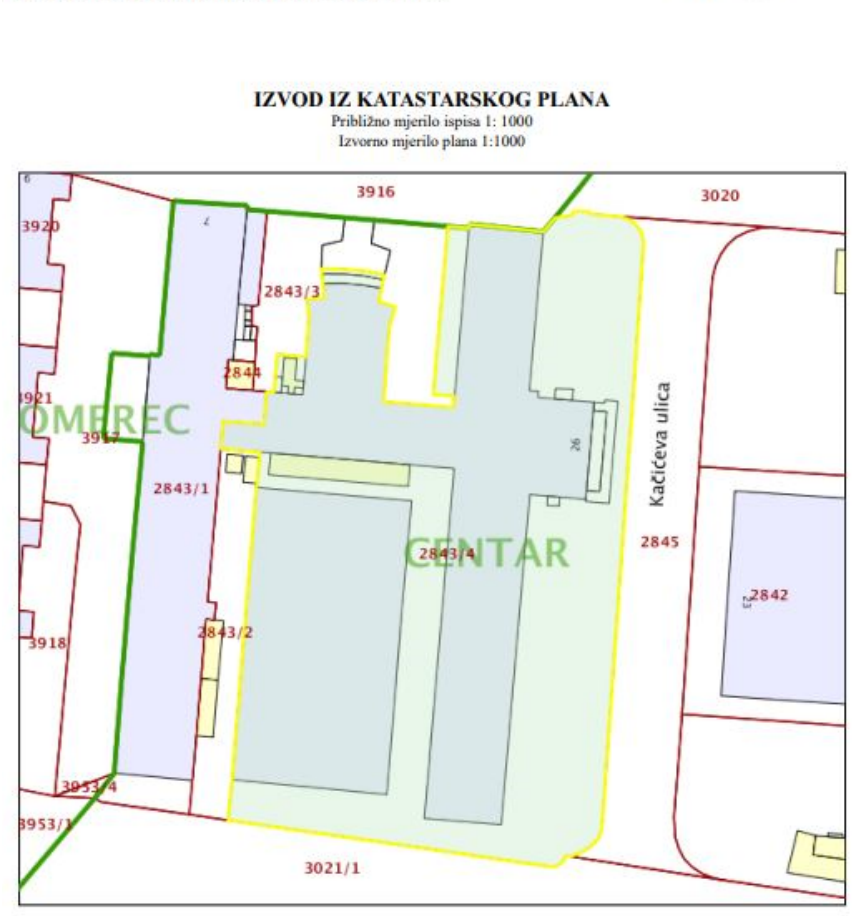
Figure 3. Cadastral map copy excerpt. Source: [29].